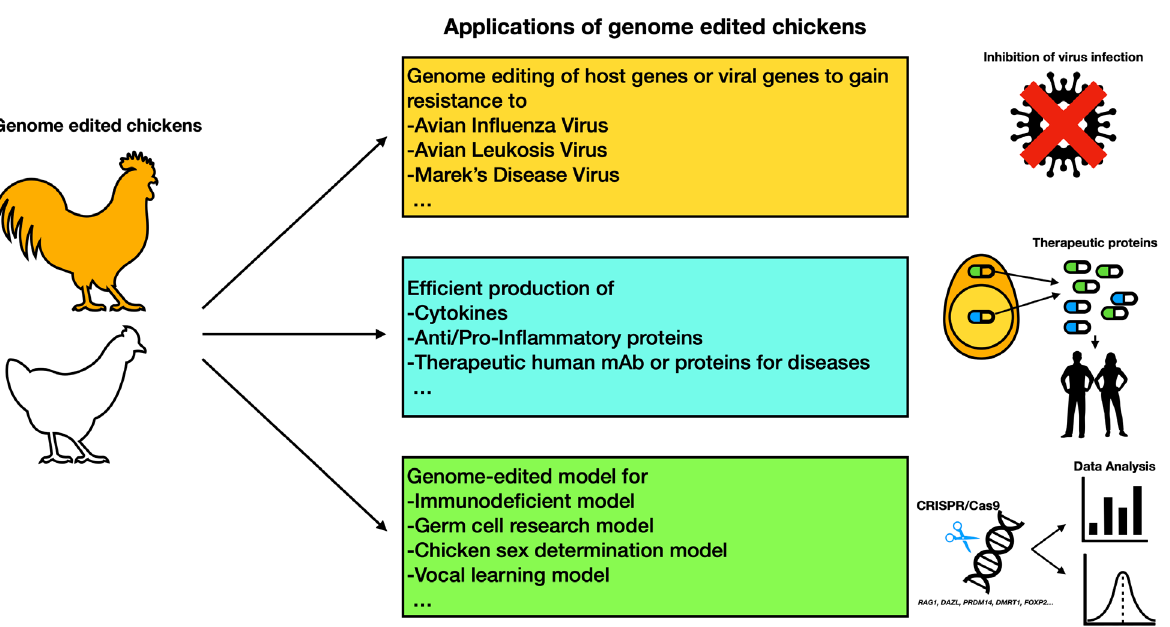
Figure 1. Representative applications of genome edited chickens. The representative examples of genome edited birds introduced in this article are shown. The viruses must use host proteins to successfully complete their life cycle and the host gene edited birds are resistant to various types of viruses, including avian influenza viruses, avian leukosis viruses and Marek’s disease viruses. The target gene encoding therapeutic proteins are inserted into the chicken genome, such as the ovalbumin gene, to produce avian bioreactor. The egg white contains a high amount of target proteins that can be used for medical purpose. The specific gene knockout or gene tagging in the chicken provided suitable model for researchers to study the gene function.